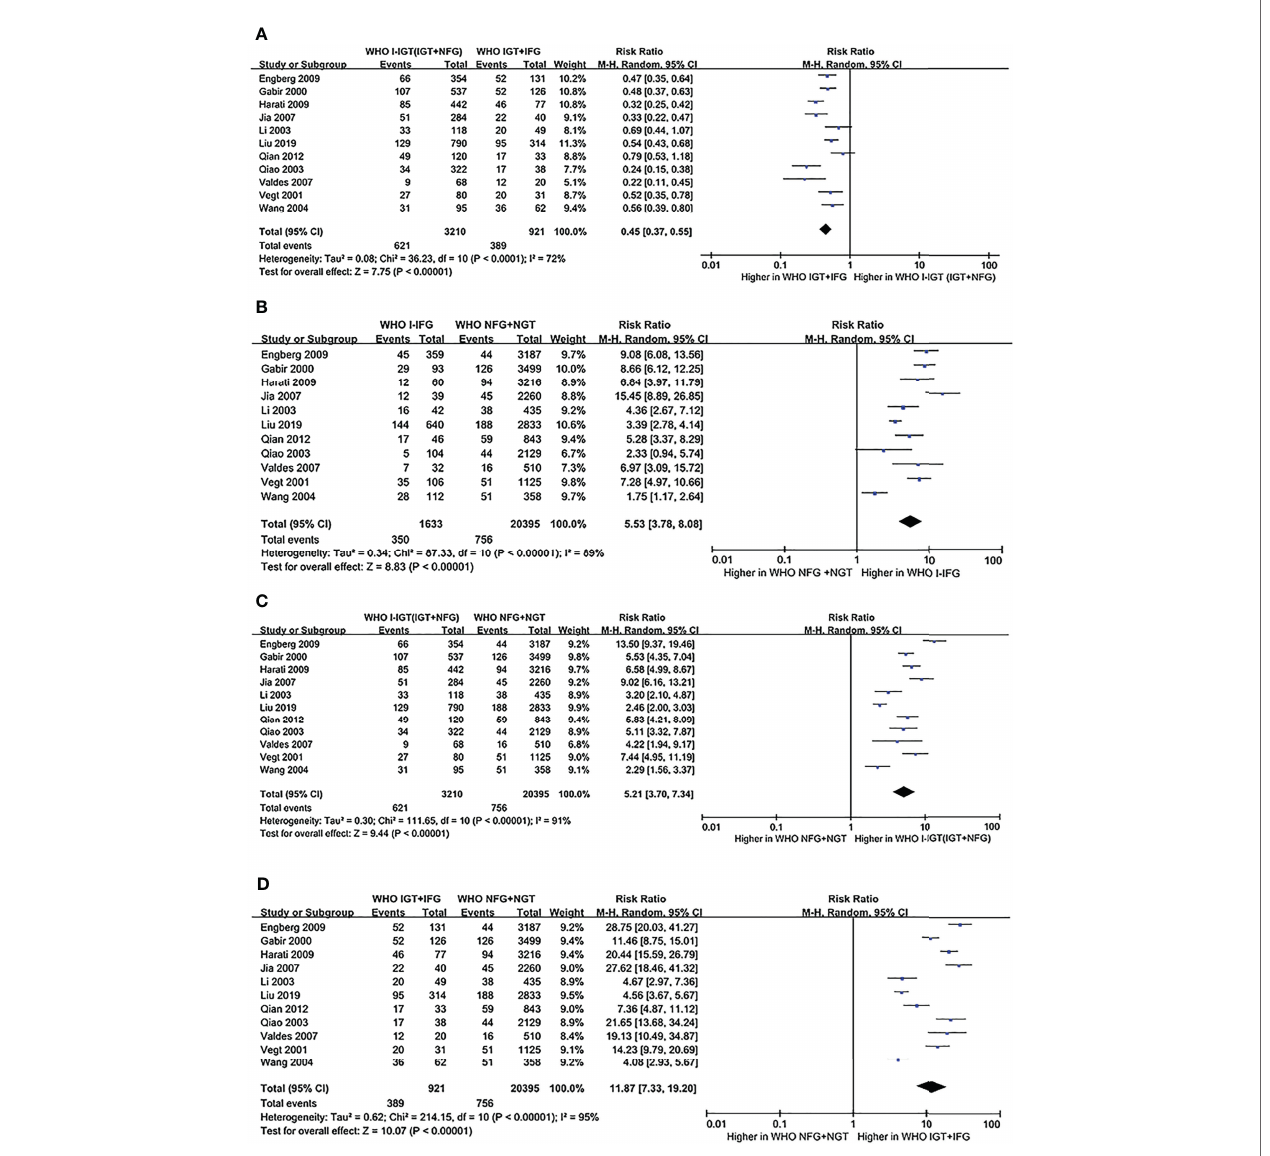
FIGURE 2 | Forest plots comparing the risk of progression to type 2 diabetes between groups according to the WHO 1999 classi fi cation criteria. (A) The risk of progression to type 2 diabetes was higher in the WHO IGT+IFG group than in the WHO I-IGT (IGT+NFG) group. (B) The risk of progression to type 2 diabetes was higher in the WHO I-IFG groups than in the WHO NFG+NGT group. (C) The risk of progression to type 2 diabetes was higher in the WHO I-IGT (IGT+NFG) than in the WHO NFG+NGT group. (D) The risk of progression to type 2 diabetes was higher in the WHO IGT+IFG than in the WHO NFG+NGT group. 95% CI, 95% con fi dence interval; I-IGT, isolated impaired glucose tolerance; IGT+IFG, impaired fasting glucose combined with impaired glucose tolerance; I-IFG, isolated impaired fasting glucose; NFG+NGT, normal fasting glucose combined with normal glucose